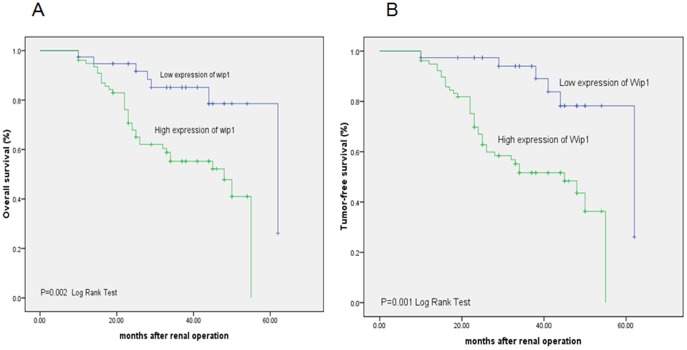
Kaplan–Meier survival curves for Wip1 expression.A, overall survival B, tumor-free survival. The patients with positive Wip1 expression displayed a significant worse outcome compared to the patients with negative Wip1 expression. (P = 0.002, log-rank test) and (P = 0.001, log-rank test).